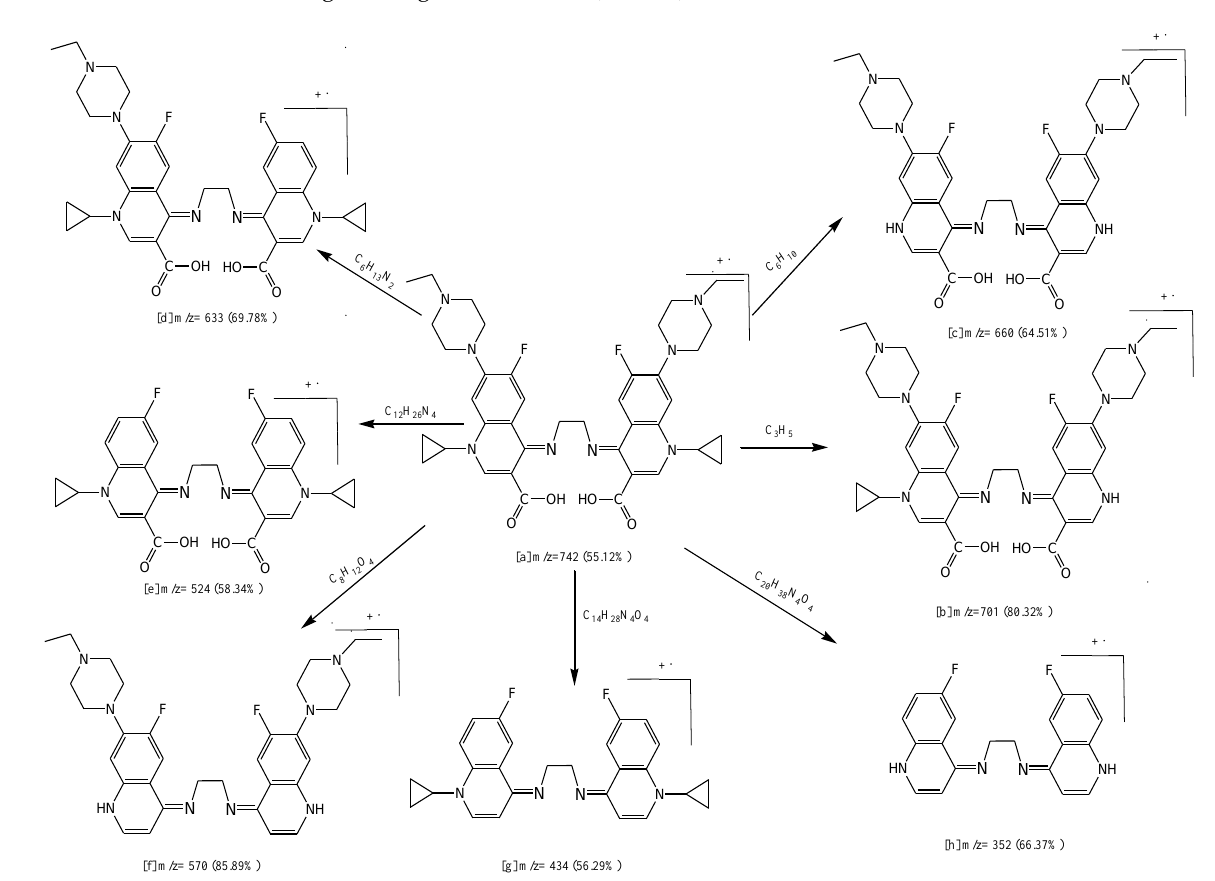
Scheme 3. Fragmentation pattern of H 2 Erx-en .